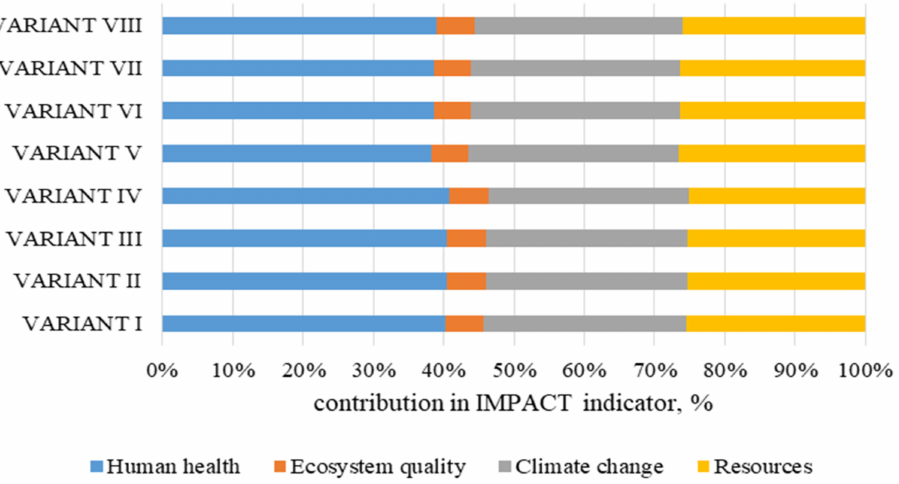
Figure 5. Share analysis of IMPACT2002+ indicator on damage category level. Table 4. Results of multi-criteria